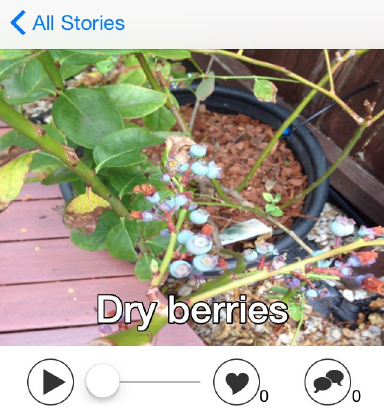
Figure 5. An image from P1’s story about his blueberry plant looking